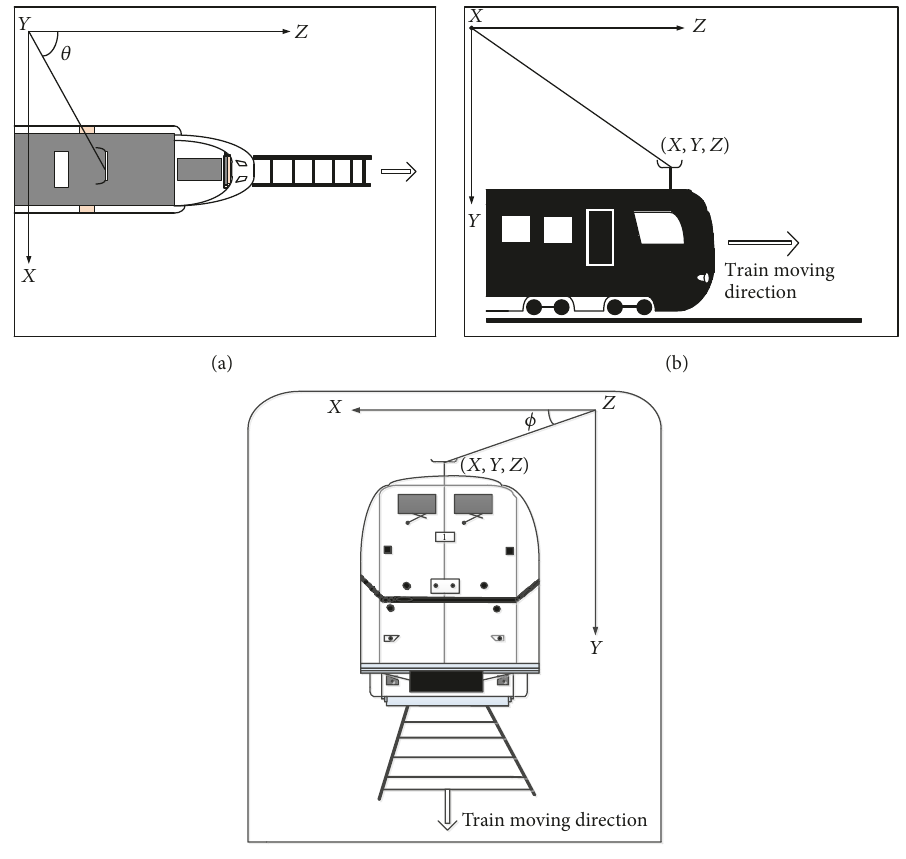
Figure 3: The three-dimensional view of radiations: (a) the nether view, (b) the side view, and (c) the obverse view.